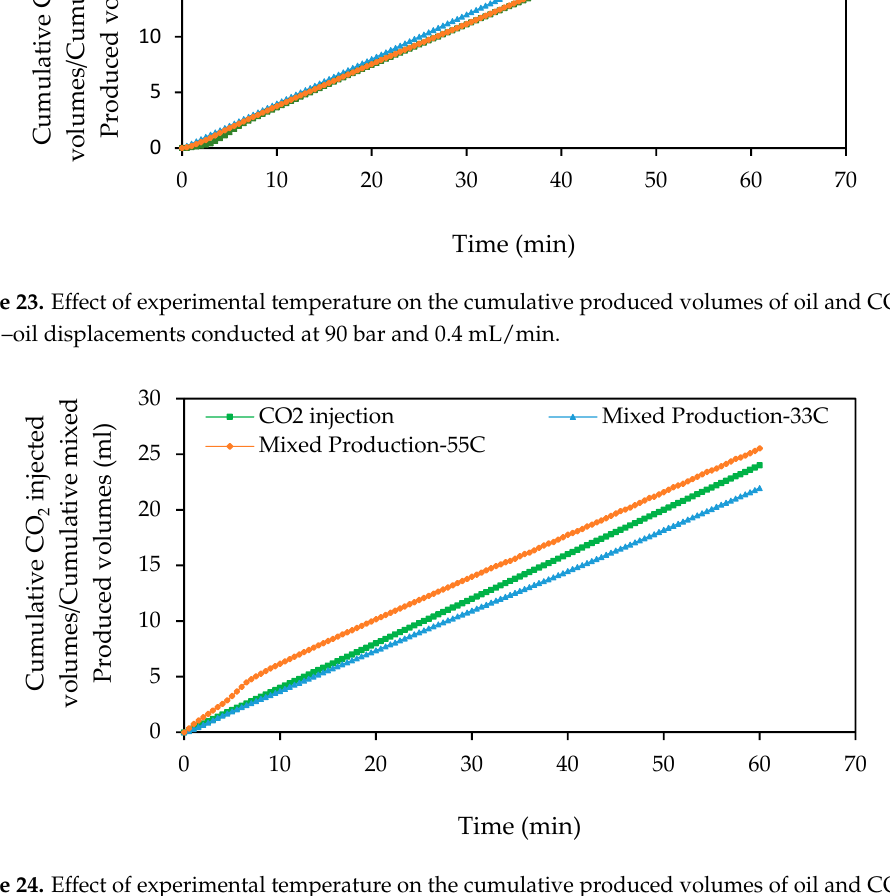
Figure 24. Effect of experimental temperature on the cumulative produced volumes of oil and CO 2 for ScCO 2 –oil displacements conducted at 90 bar and 0.4 mL/min.